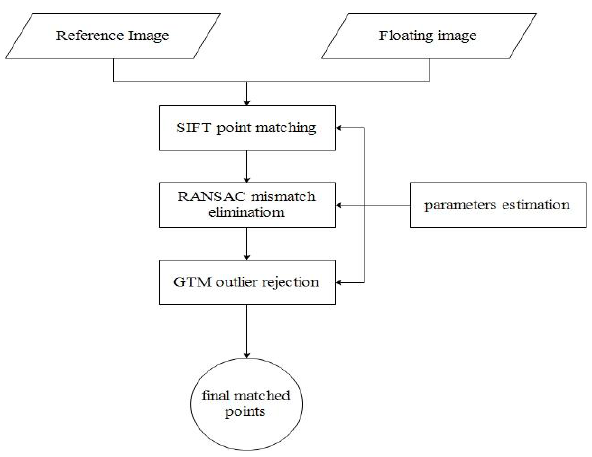
Figure 4. Steps of the presented matching